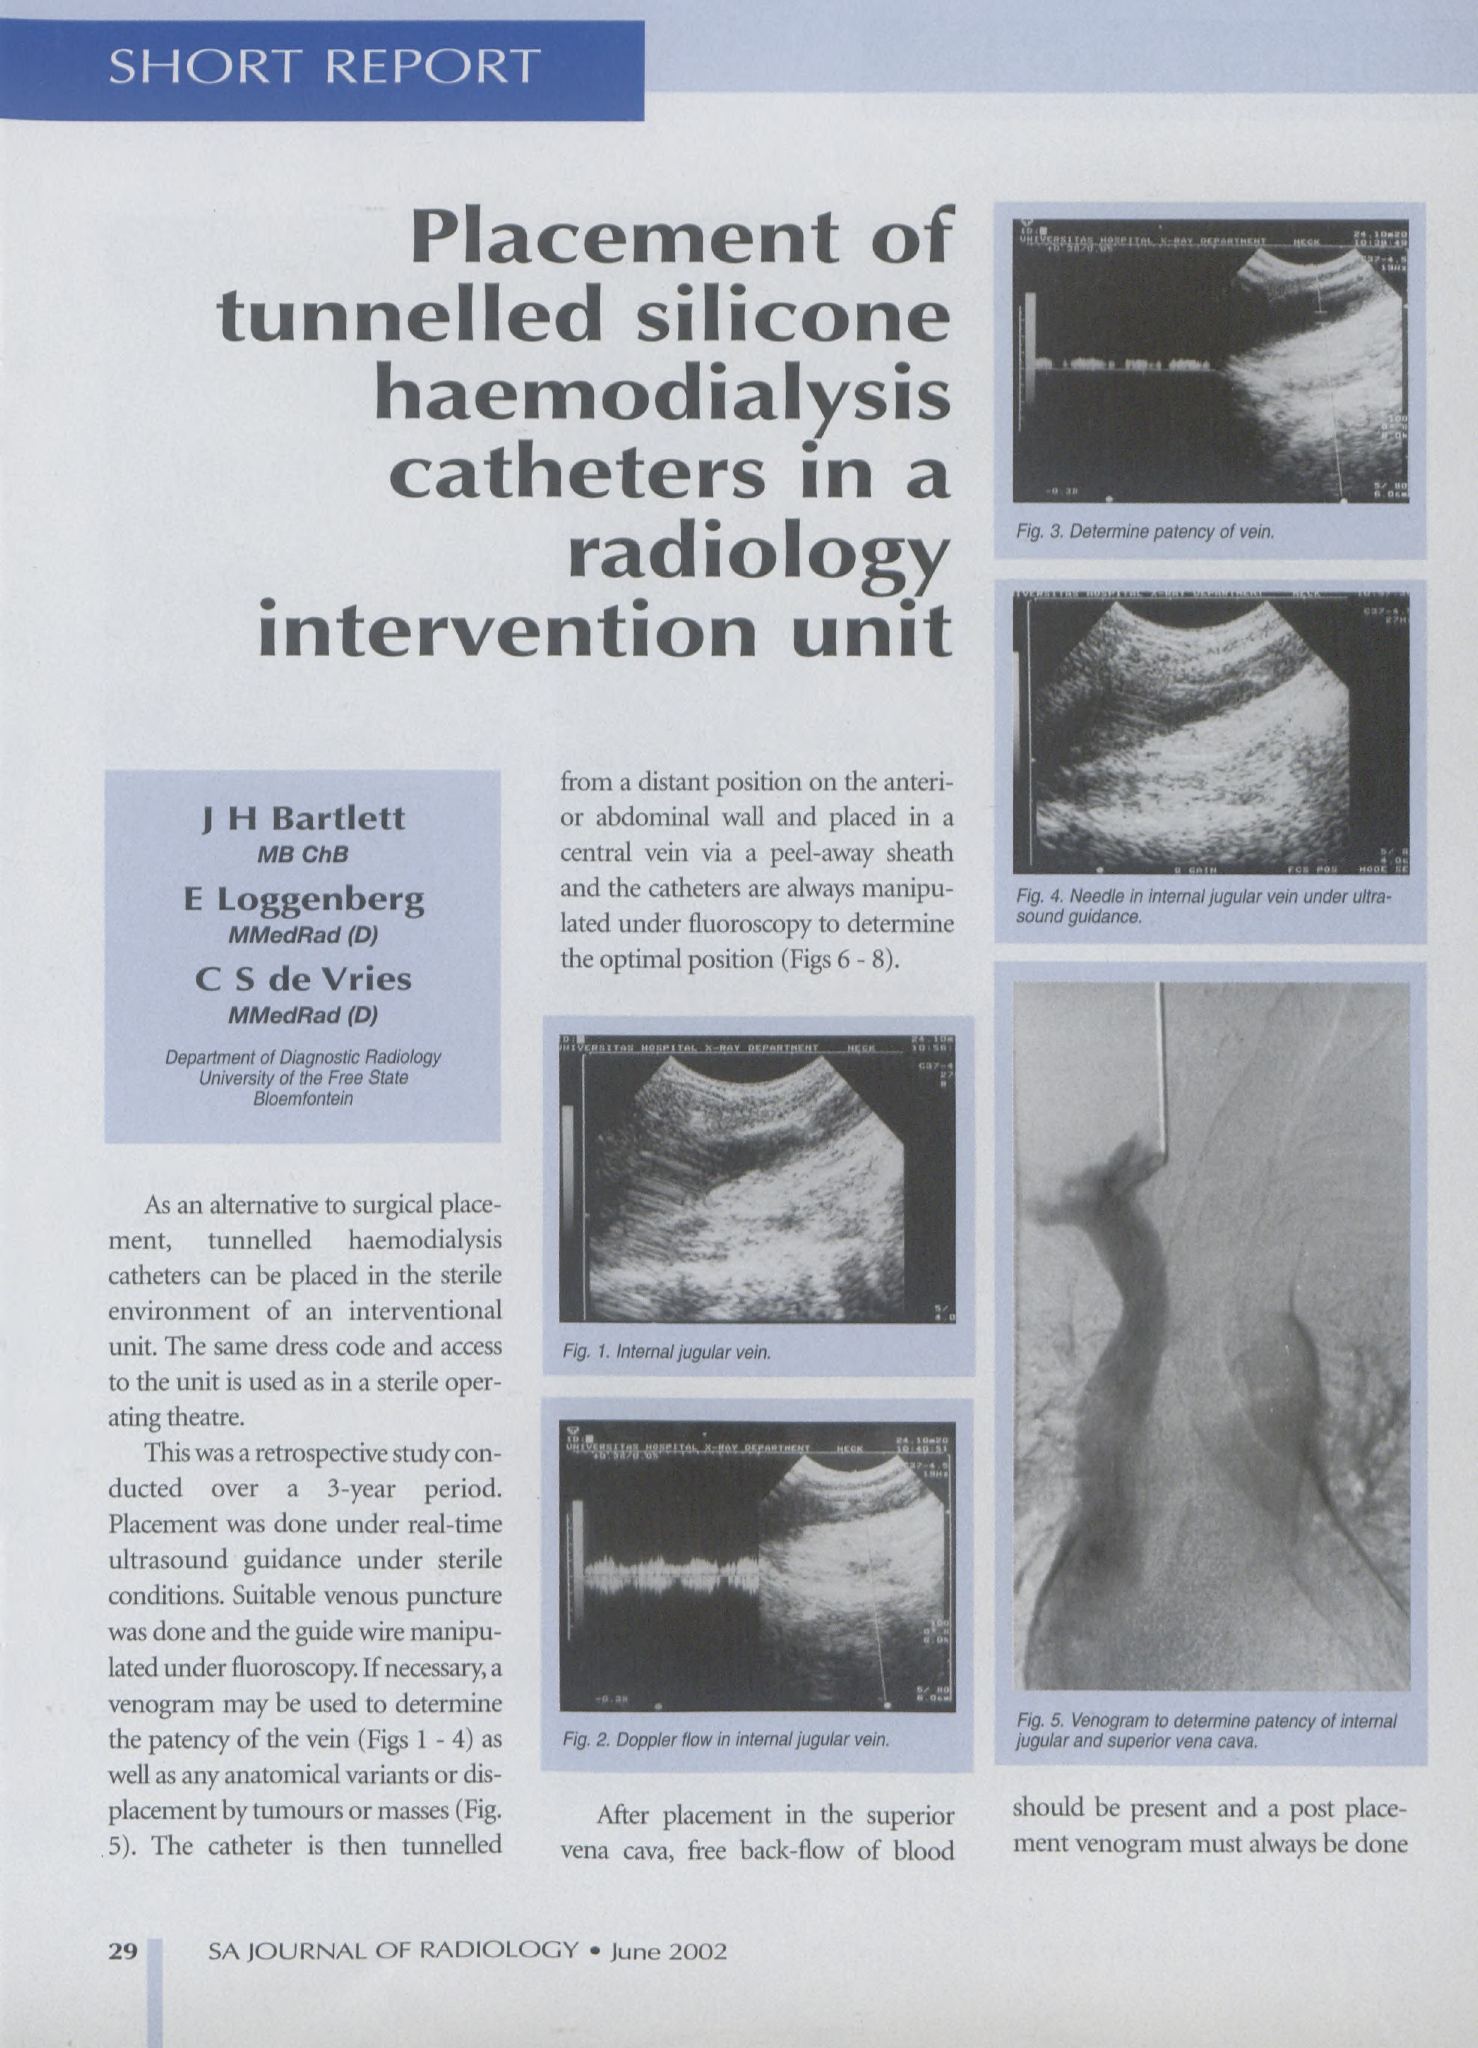
Fig. 2. Doppler flow In internal jugular vein.